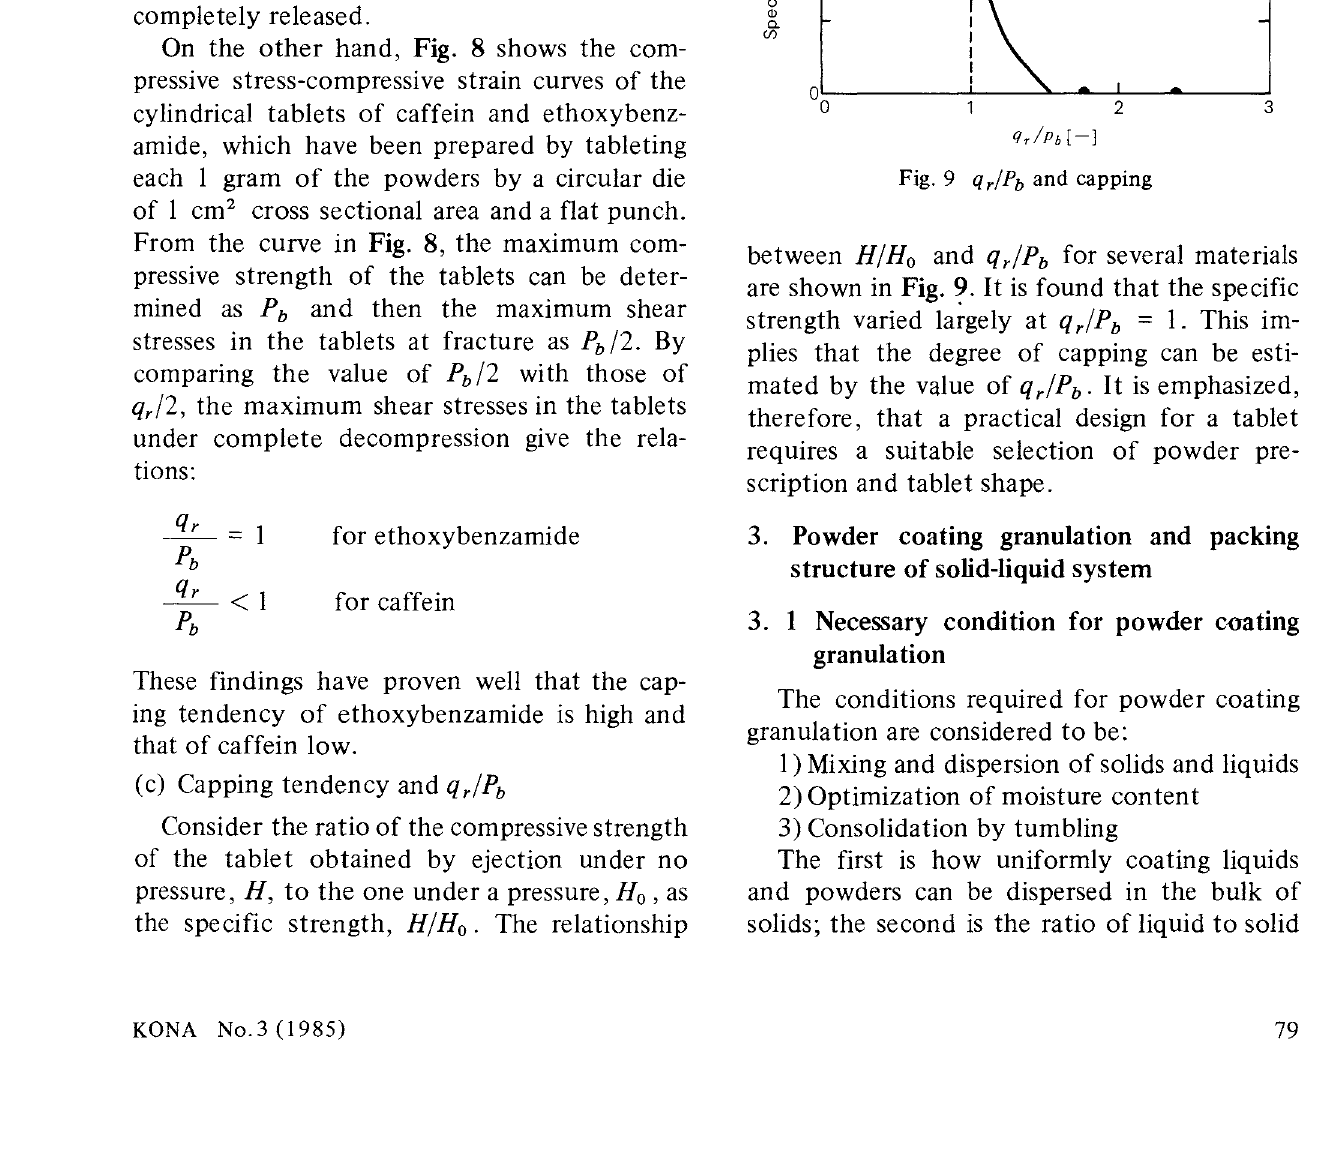
Fig. 8 Compressive fracture test